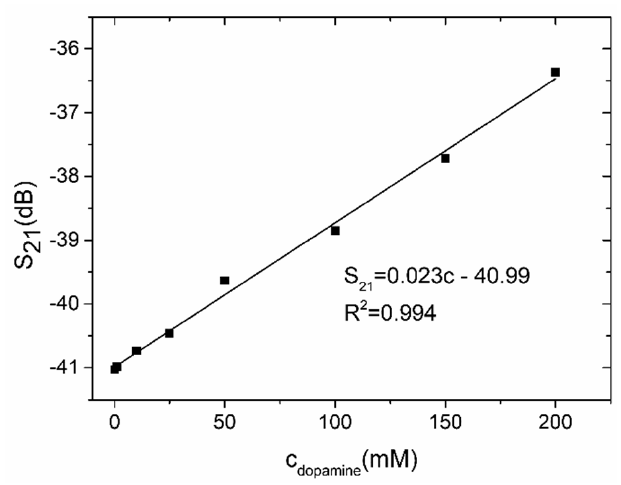
Figure 18. Transmission coefficient as a function of dopamine.